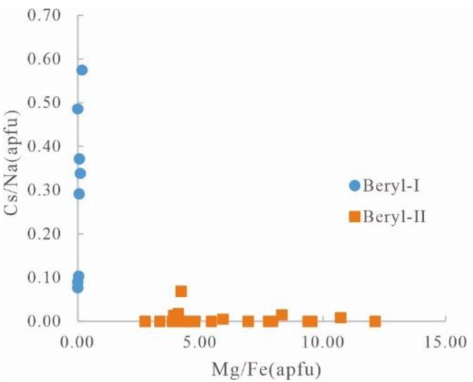
Figure 11. Mg/Fe vs. Cs/Na diagram of beryl from the Xianglin